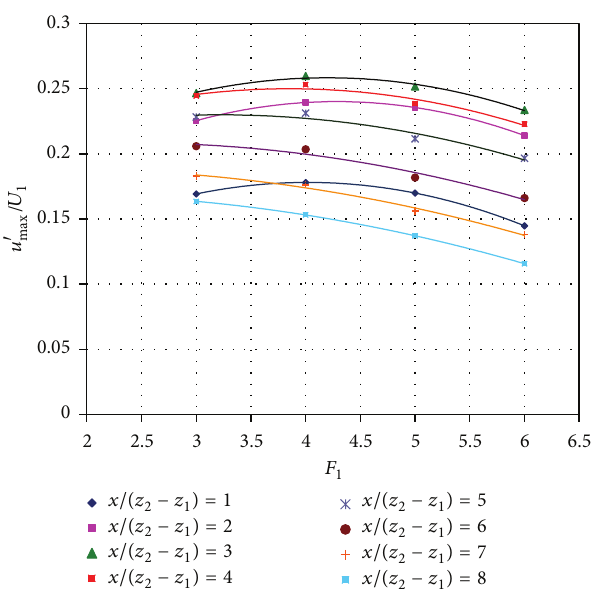
Figure 5: Maximum velocities below hydraulic jumps near the floor as a function of 𝐹 1 .